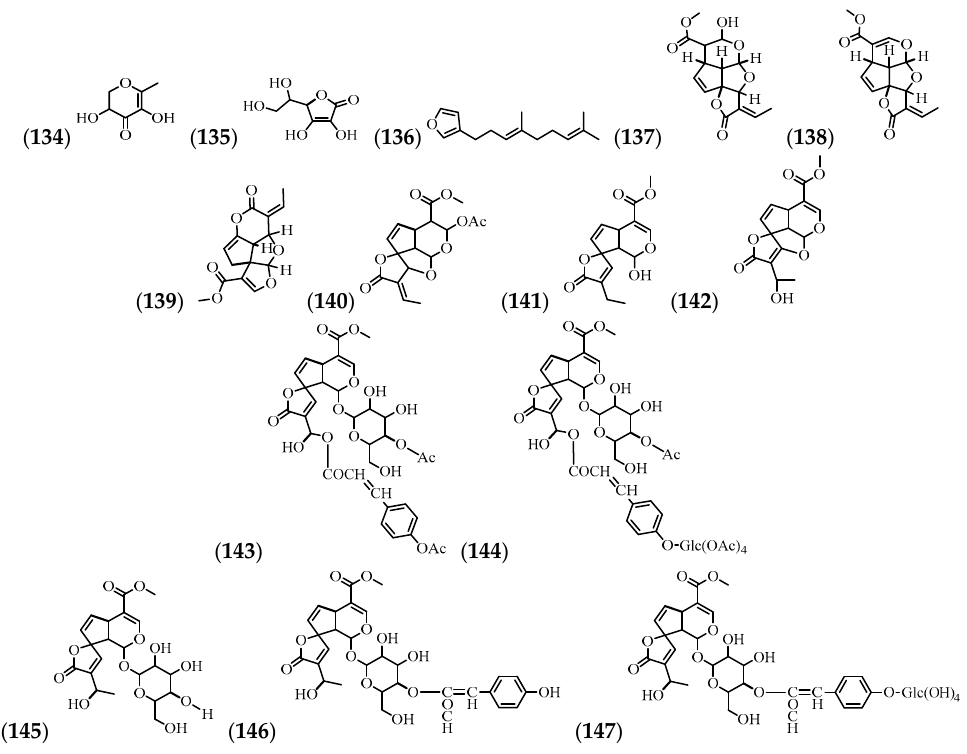
Figure 9. The structures of the lactones from A. cathartica .